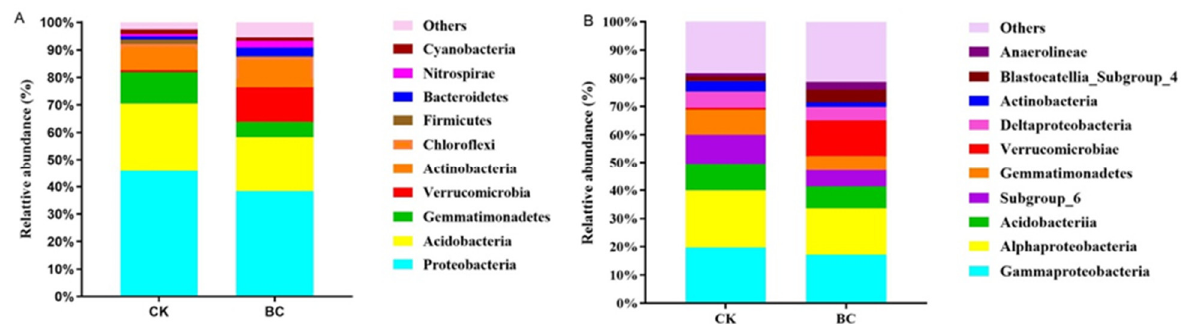
Figure 4. Effect of biochar on relative abundance of bacterial phyla ( A ) and class ( B ). CK, conventional fertilizer; BC, biochar with conventional fertilizer.